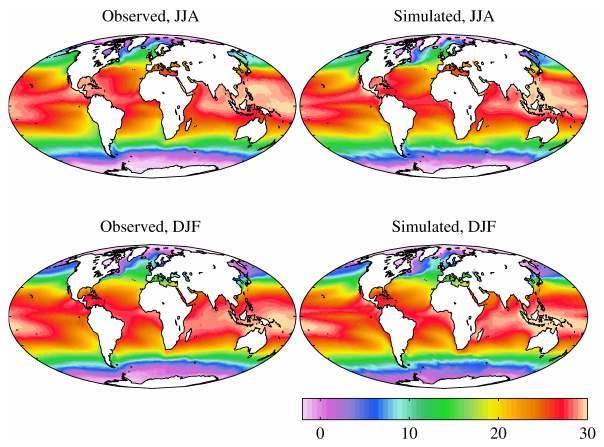
Fig. 4. Observed (left) and simulated (right) sea surface temperature Fig.4. Observed( left )andsimulated( right )seasurfacetemperaturefortheperiodsJune–July–August(JJA; top )and December–January–February(DJF; bottom ). Averagesbasedontheperiod2000–2009inclusive. Temperaturein ◦ C. for the periods June-July-August (JJA; top) and December-January- February (DJF; bottom). Averages based on the period 2000–2009 inclusive. Temperature in ◦ C.